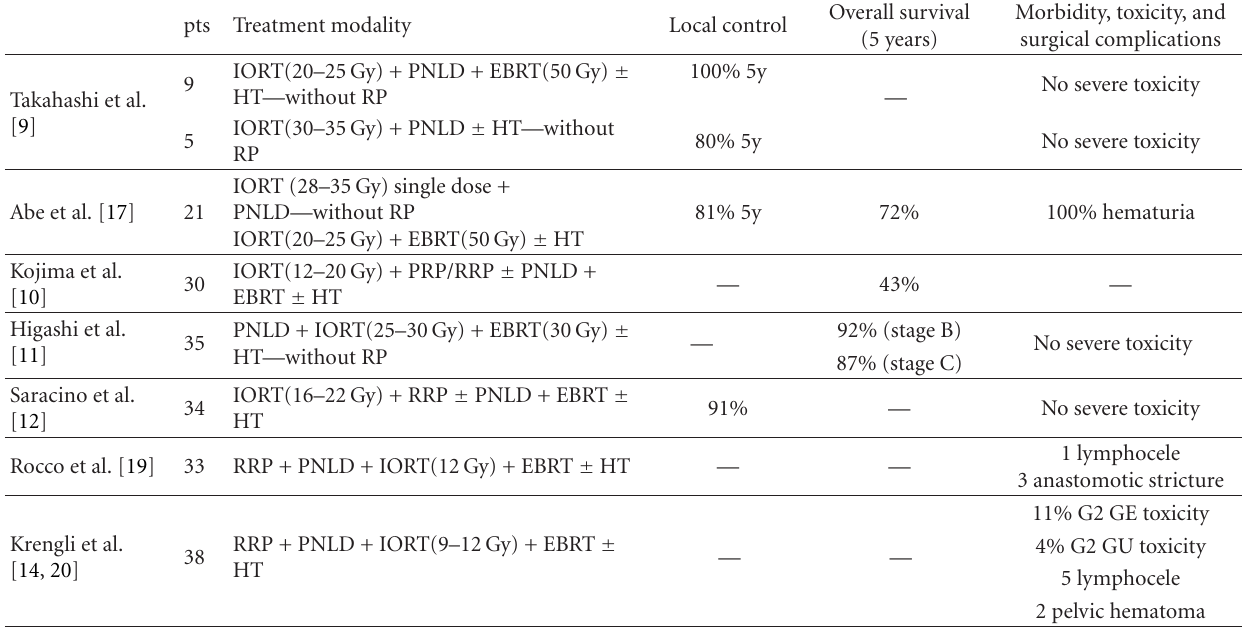
Table 1: Treatment modality and outcomes of selected series of IORT in prostate cancer. pts Treatment